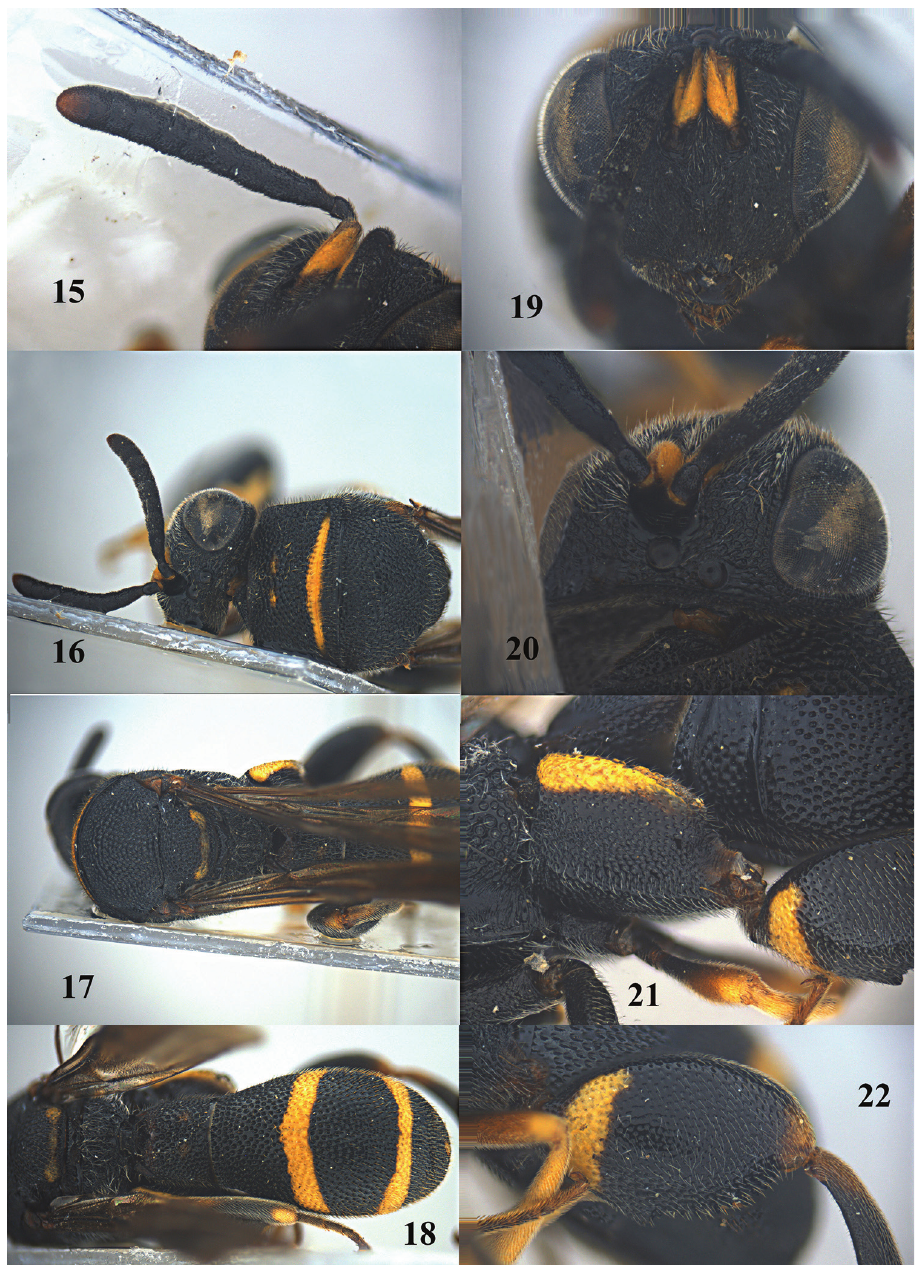
Figures 15–22. Leucospis japonica Walker, ♂ from Guangdong, Guangyinshan. 15 Antenna 16 head and pronotum dorsal 17 mesosoma dorsal 18 propodeum and metasoma dorsal 19 head frontal 20 head latero-dorsal 21 hind coxa 22 hind